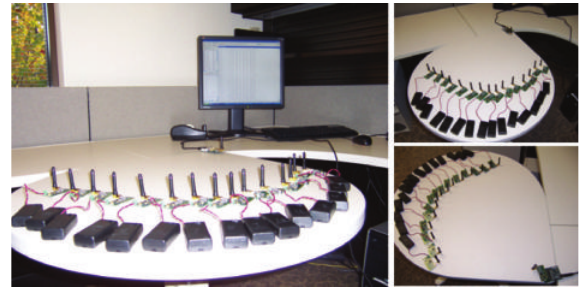
Figure 9: Experiment setup number 2: nodes on a table close to base